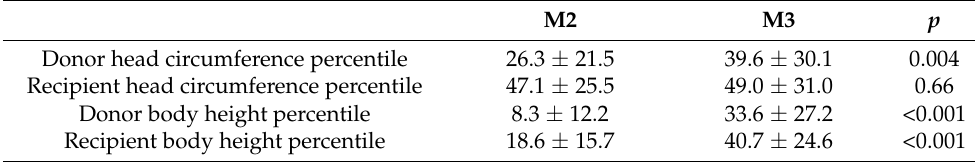
Table 3. Head circumference percentiles and body height percentiles at M2 and